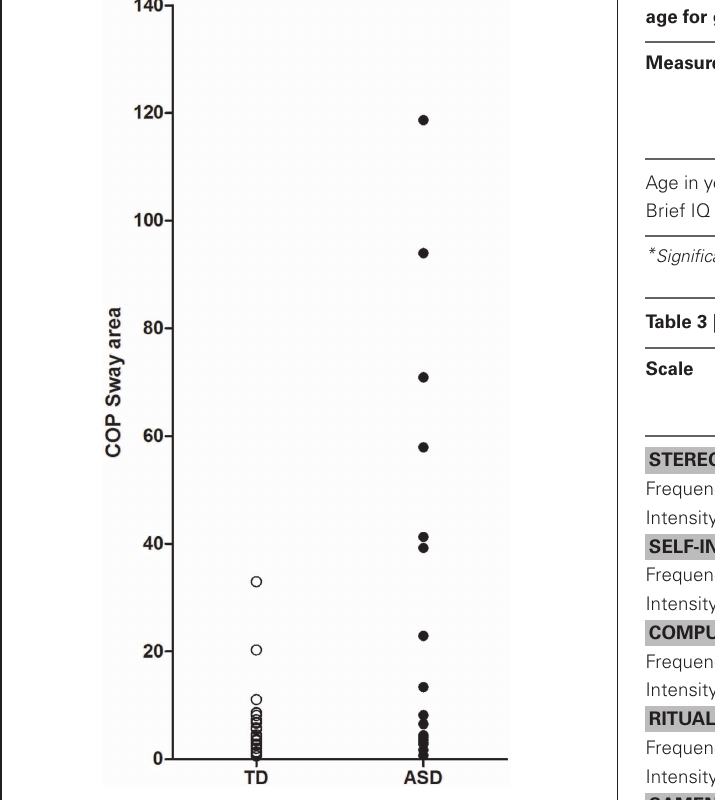
RBS-R frequency and intensity scores ( r = 0 . 61, p < 0 . 01; r = 0 . 61, p < 0 . 01), as well as 5 out of the 6 subscale scores ( r range of 0.46–0.62, all p < 0 . 01). Sway area was not related to the Self-injurious Behavior subscale (frequency r = 0 . 22, p > 0 . 05; intensity r = 0 . 13, p > 0 . 05).